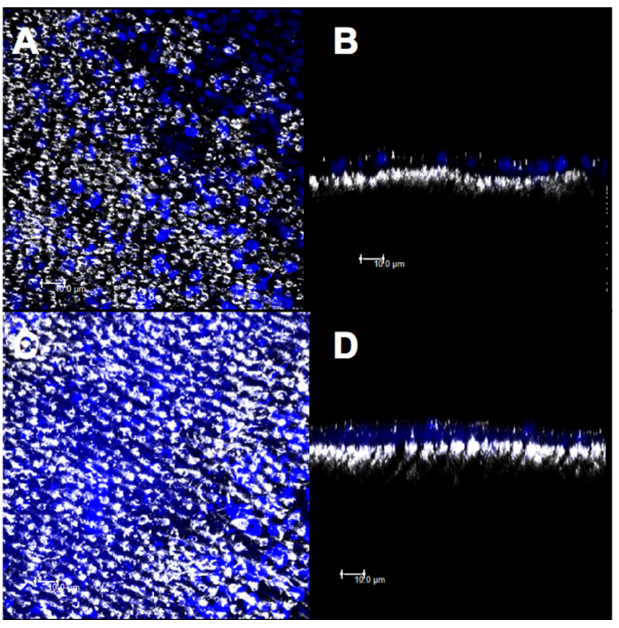
Figure 9. Confocal laser scanning microscopy images (fluorescence mode) in XY and XZ axis of dentin surface. ( A , B ) Adhesive with nanofiber and ( C , D ) after 6% citric acid challenge.